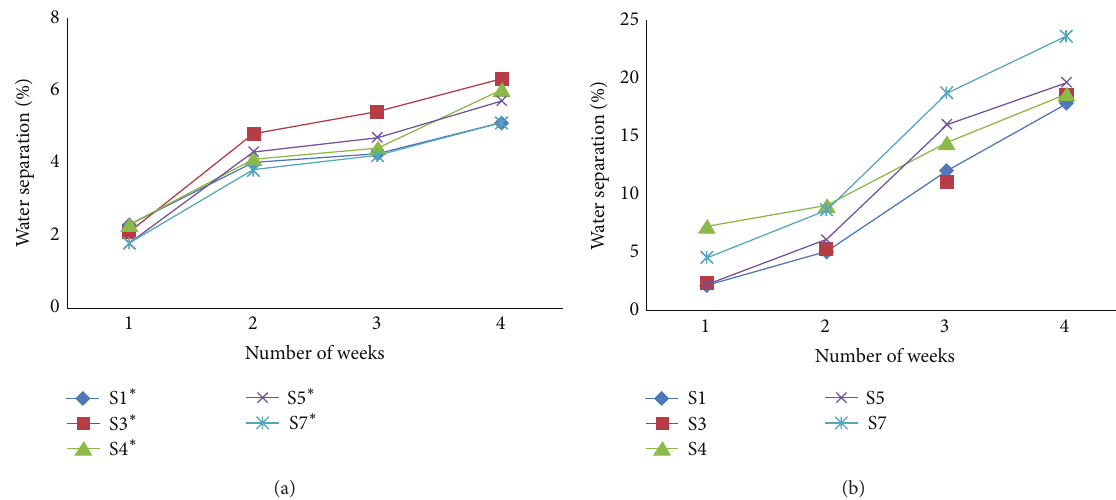
Figure 3: Percentage of syneresis during four freeze-thaw cycles. ∗ Hydroxypropylated starch (water separation of hydroxypropylated starch (a) and water separation of native starch